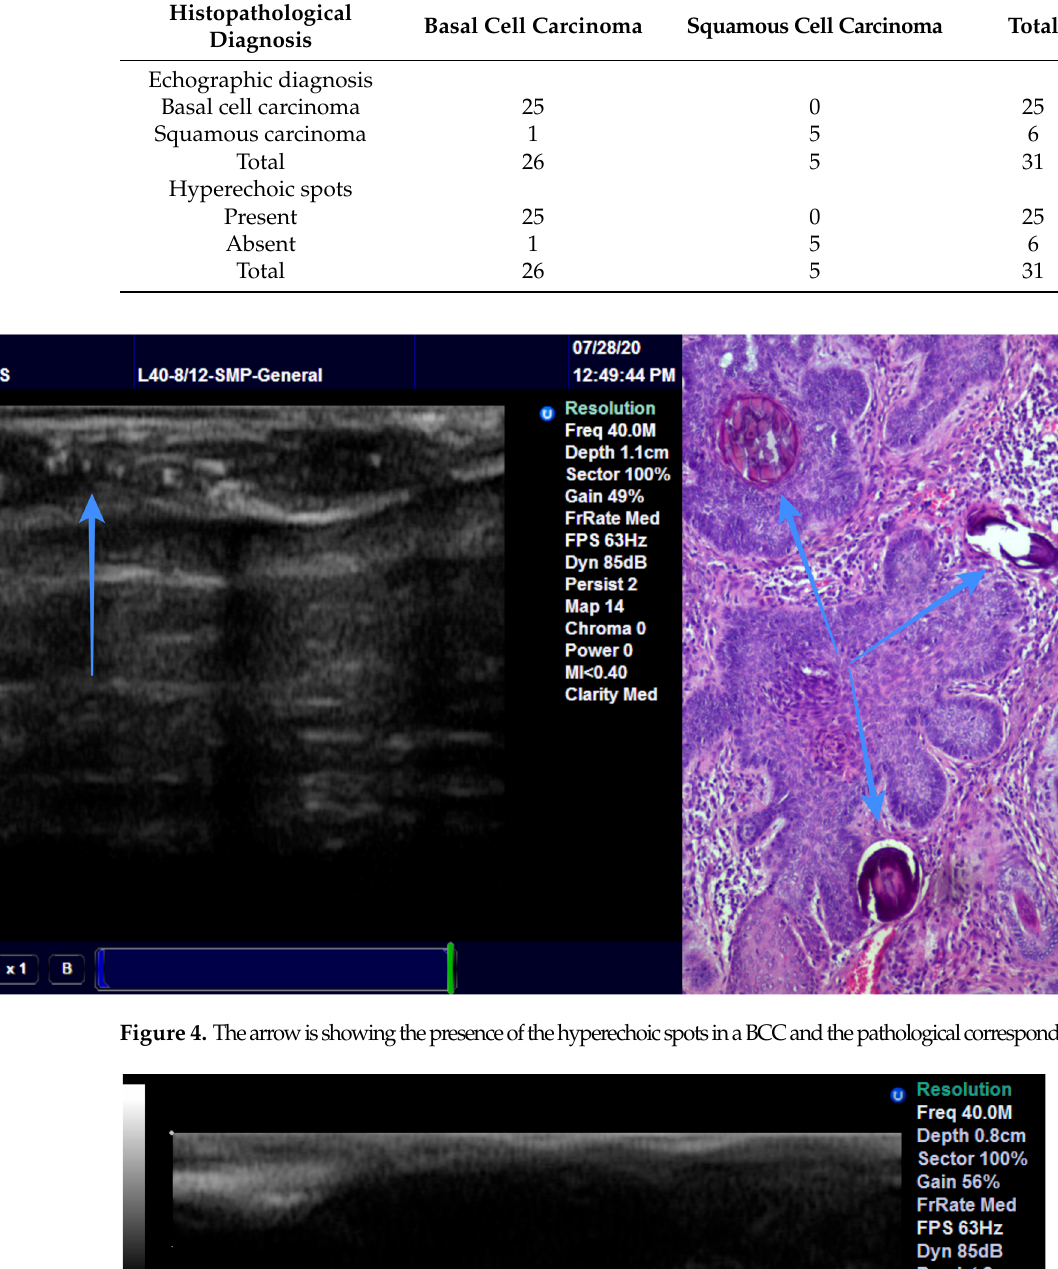
Table 3. Concordance between histopathological diagnosis, echographic diagnosis and hyperechoic spots.